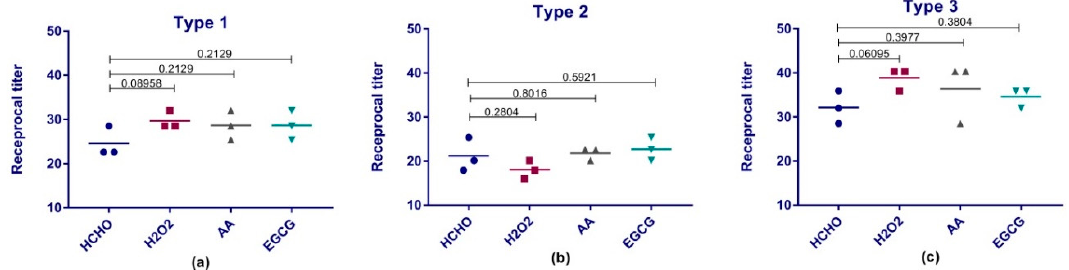
Figure 4. Sabin viruses neutralizing antibodies against PV serotypes. Titers of neutralizing antibodies obtained from each group of rat sera after immunization with one of the four vaccine preparations were tested via tissue culture technique. Titers are expressed as reciprocals. The test was performed in triplicate for each serotype and the geometric mean titers (GMT) are represented by horizontal lines. The capped lines represent the compared groups and the numbers written above the capped lines are the p -values. ( a ) PV1, ( b ) PV2 and ( c ) PV3.